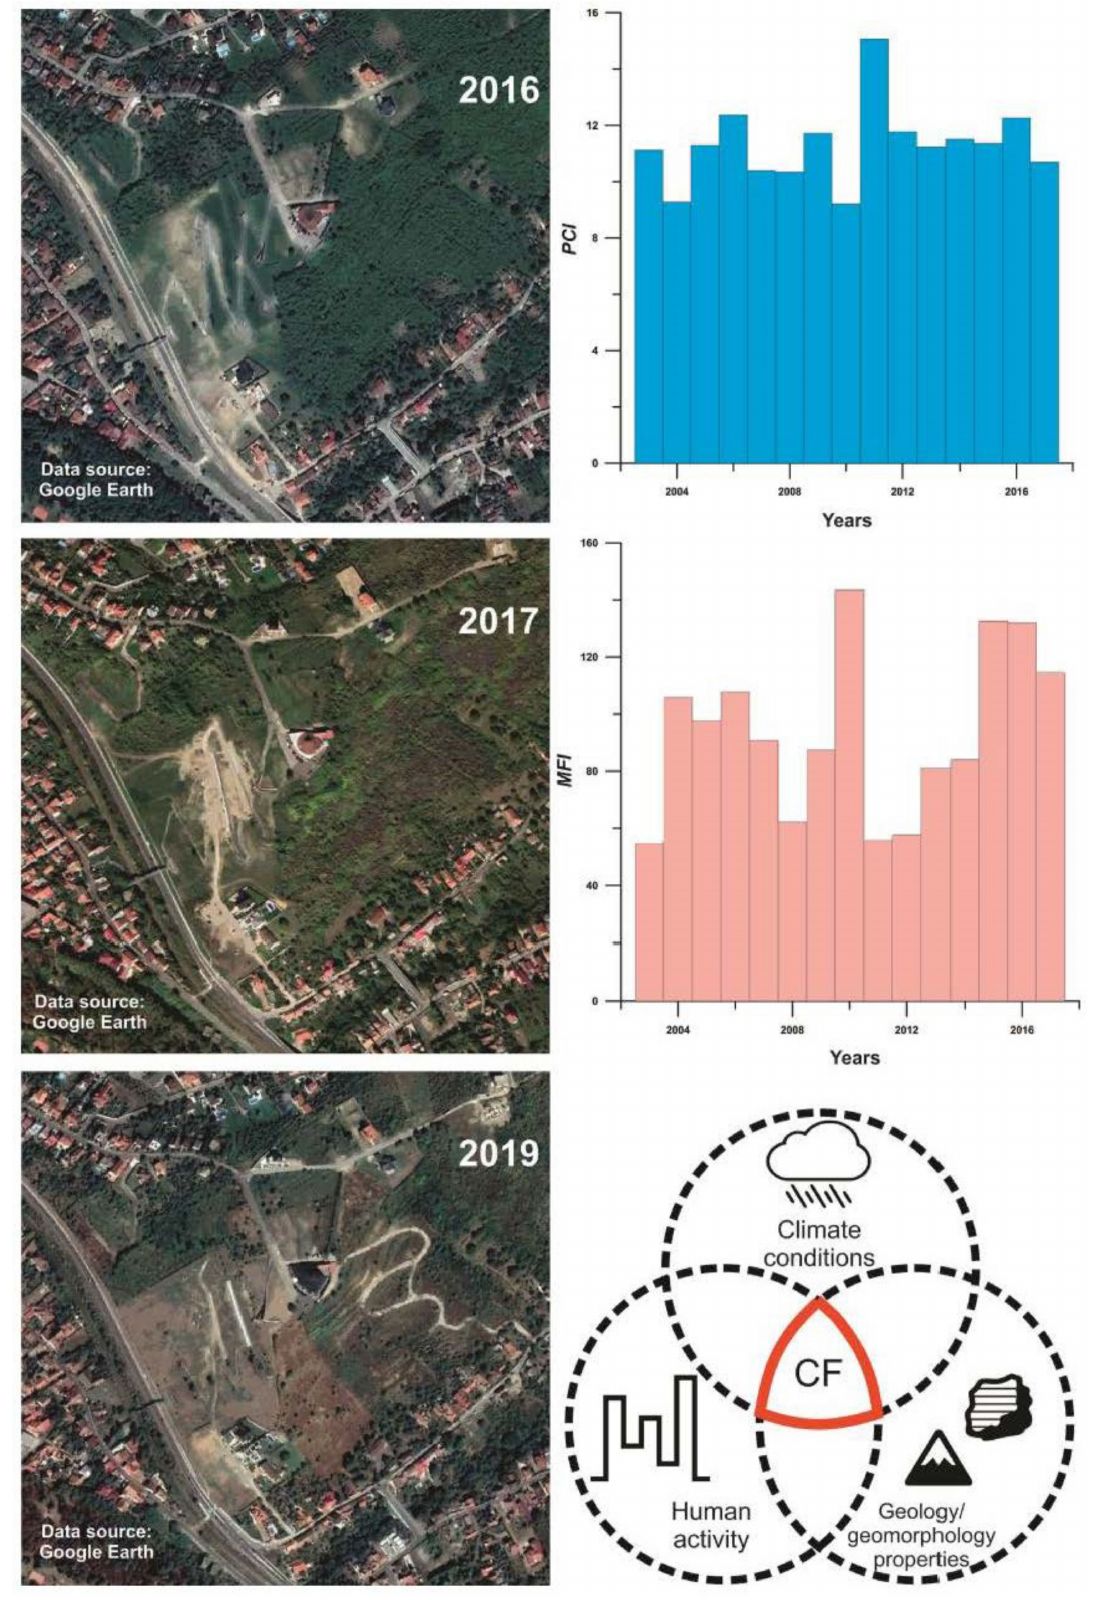
Figure 10. The time sequence of landslide event. Data source: derived after